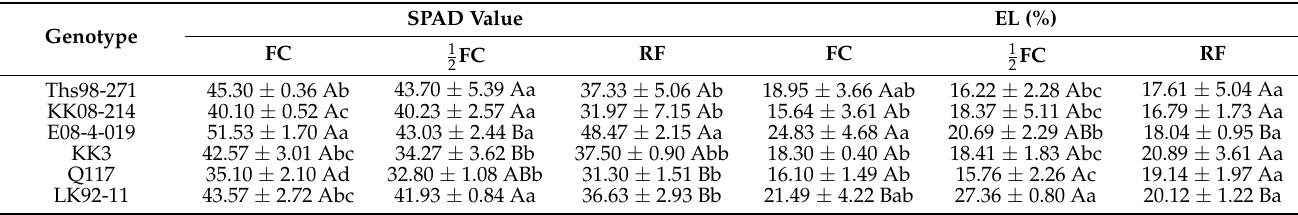
Table 3. Soil Plant Analysis Development (SPAD) value and electrolyte leakage (EL) of six sugarcane genotypes under early drought conditions (determined four months after planting).